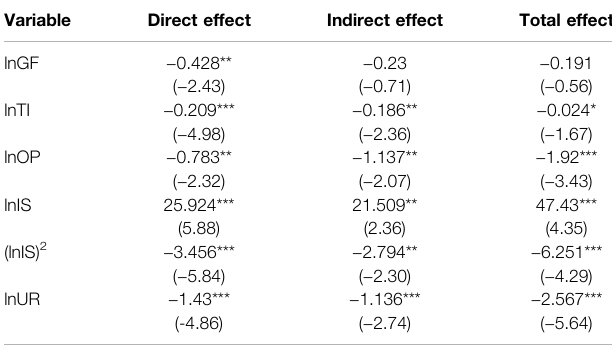
TABLE 12 | The results of the spatial effect.